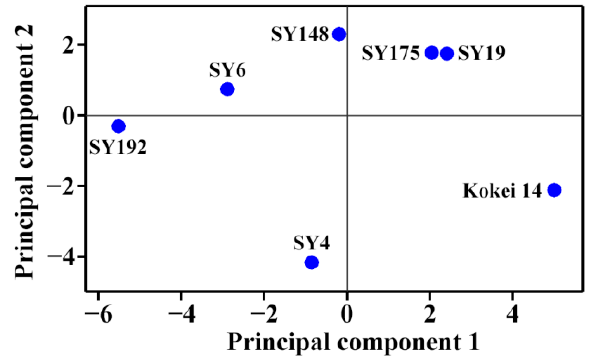
Figure 6. Score plot of PCA based on the molecular components and heat properties of C-type starches.